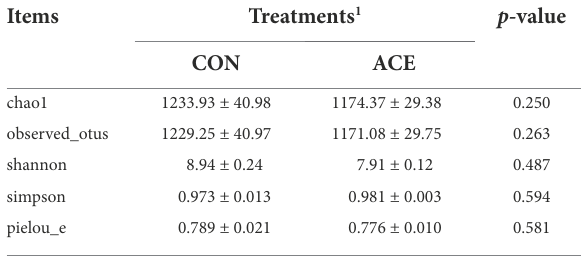
TABLE 3 Effects of dietary NAc supplementation on α -diversity indexes of rumen bacteria.